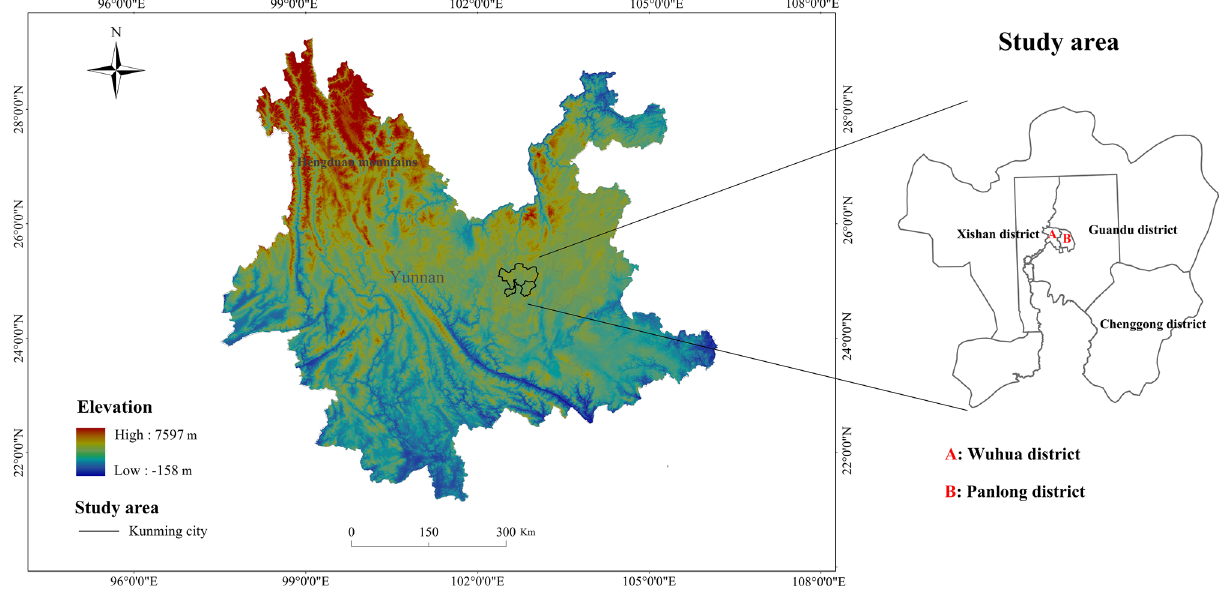
Figure 5. The location of the study area. This map was generated by Arcgis10.2 (https:// www. esri. com/ en- us/